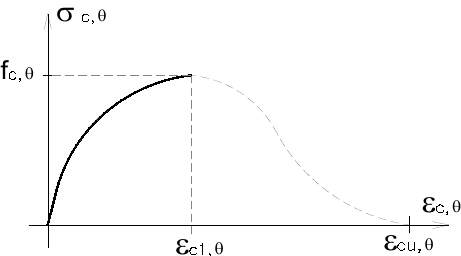
Figure 5. Stress-strain relationship of concrete at elevated temperature.